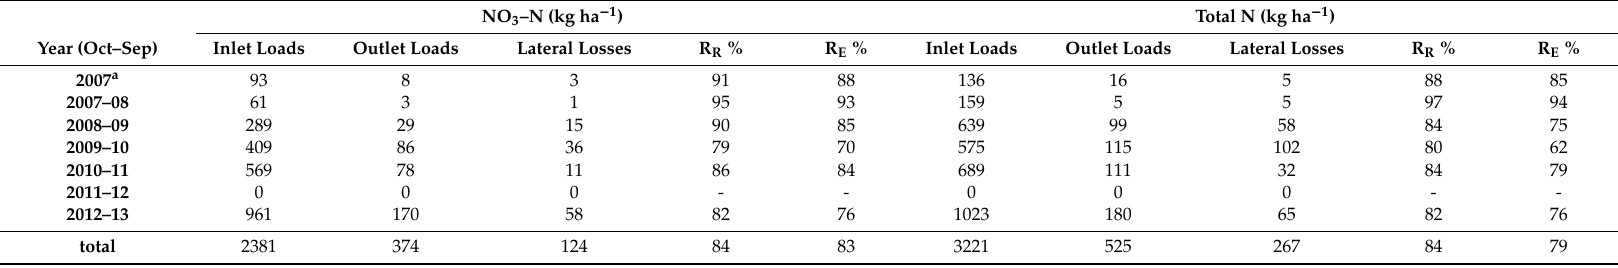
Table 3. SFWC nitrogen balance (NO 3 –N and total N). Inlet and outlet loads, estimated lateral losses, removal ratio (R R ), and removal e ffi ciency (R E ) are reported.